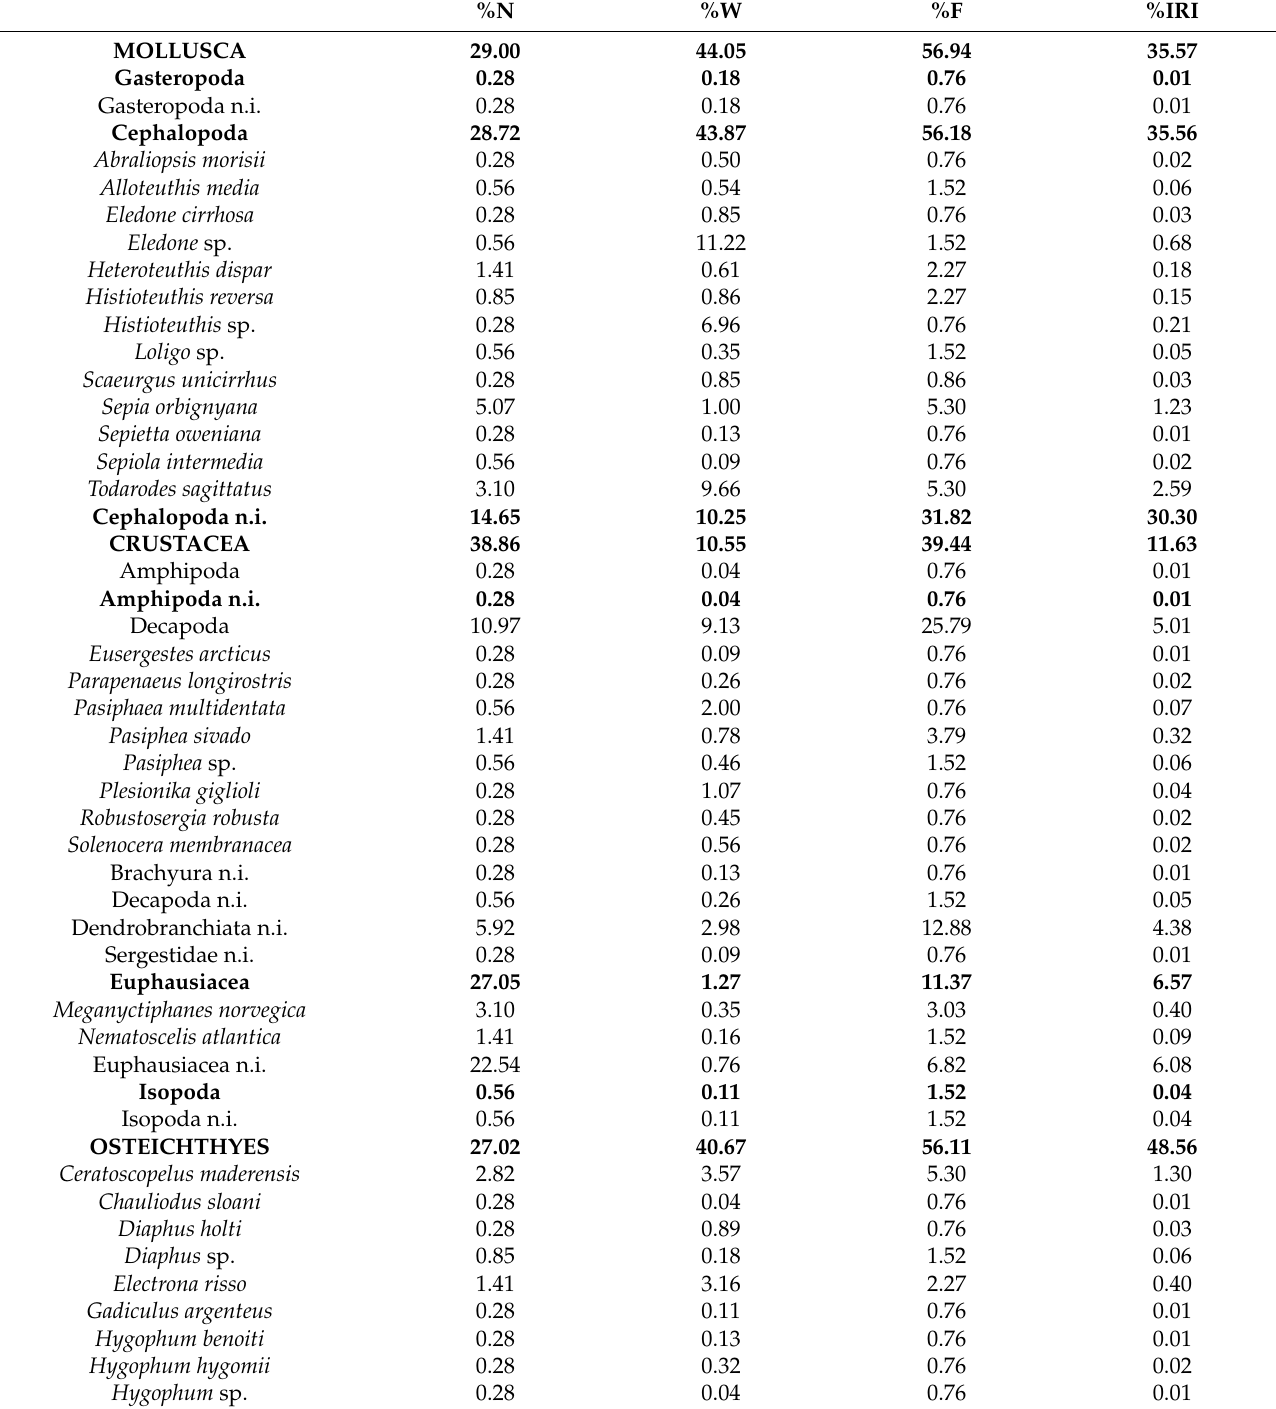
Table 2. Diet composition of G. melastomus from the southern Tyrrhenian Sea (western Mediterranean Sea). %F = percentage frequency of occurrence; %N = percentage in number; %W = percentage in biomass; IRI = index of relative importance of prey items and its percentage (%IRI). Numbers in bold are sums of indices for main